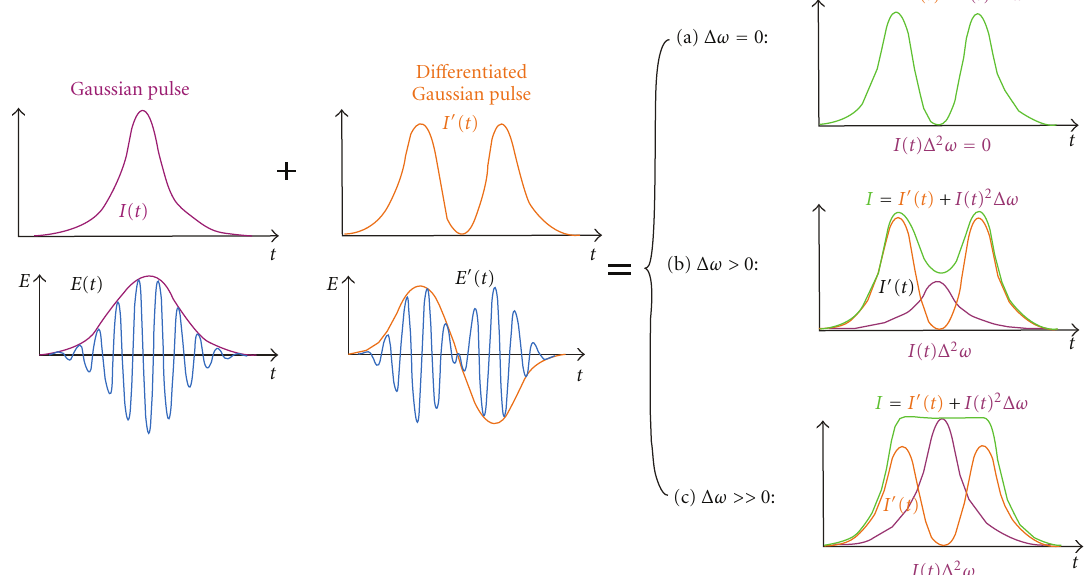
Figure 2: Principle of flat-top pulse generation using a frequency-detuned optical di ff erentiator, Δ ω = ω car − ω 0 .